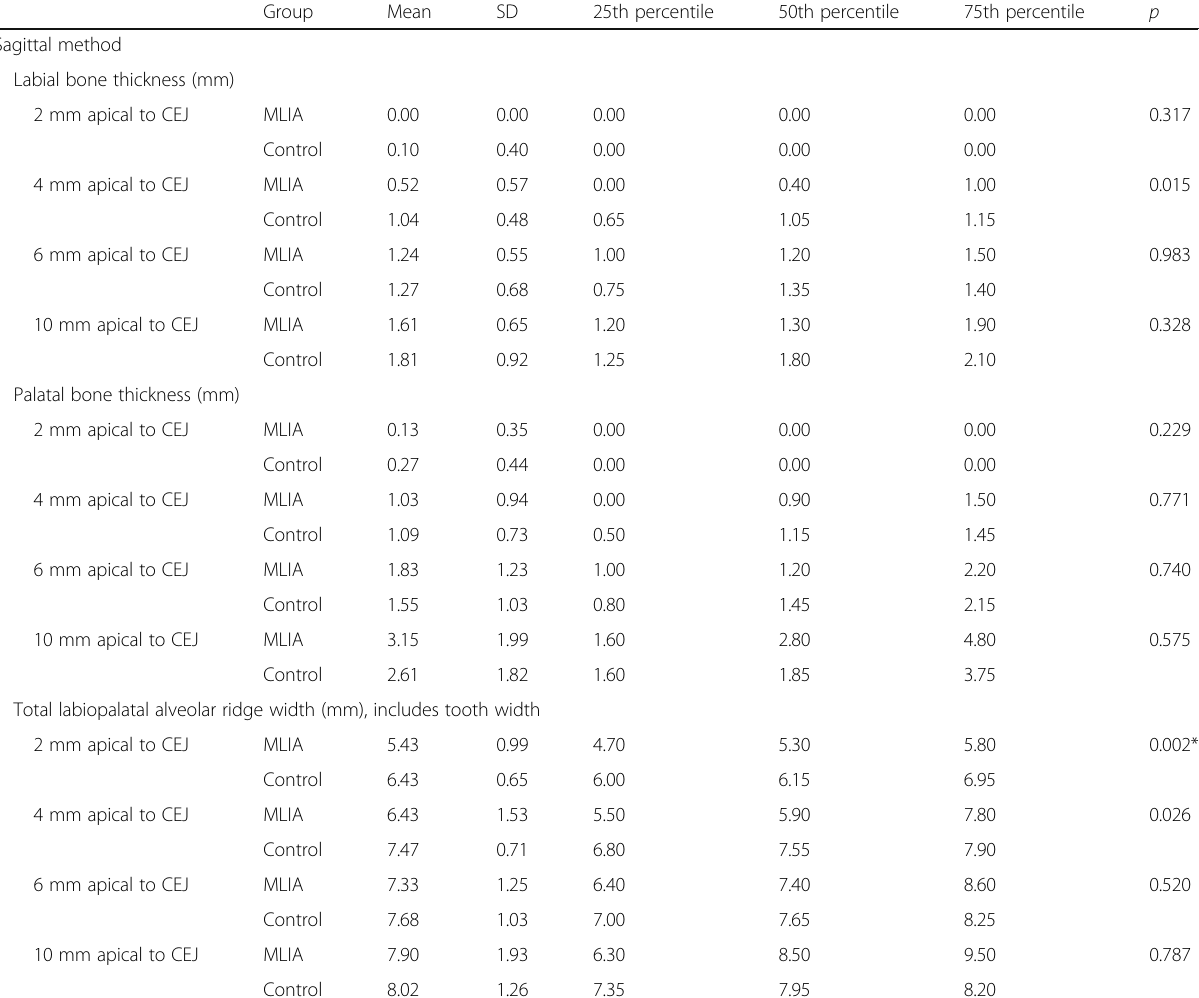
Table 4 Bone thickness parameters measured from sagittal sections Group Mean SD 25th percentile 50th percentile 75th percentile p Sagittal method Labial bone thickness (mm) 2 mm apical to CEJ